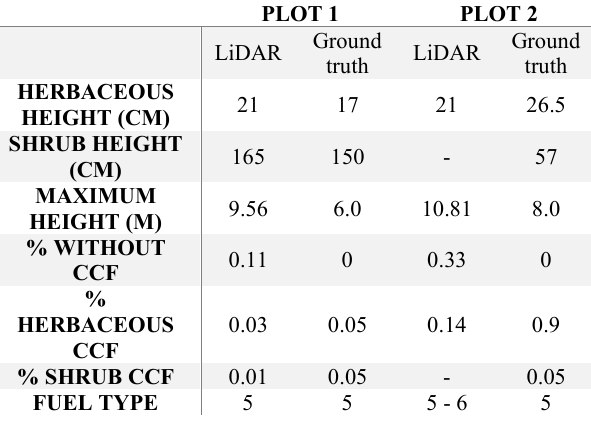
Table 1. Comparison results of LiDAR data and ground